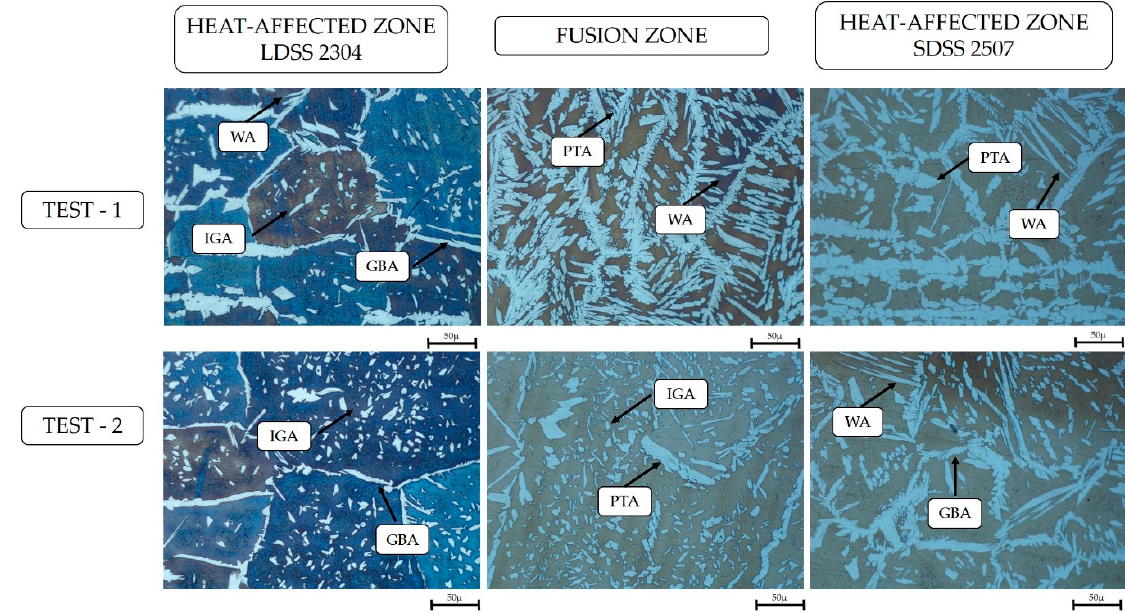
Figure 5. Welded zones by optical microscope to 50 × : 130 A welding current.